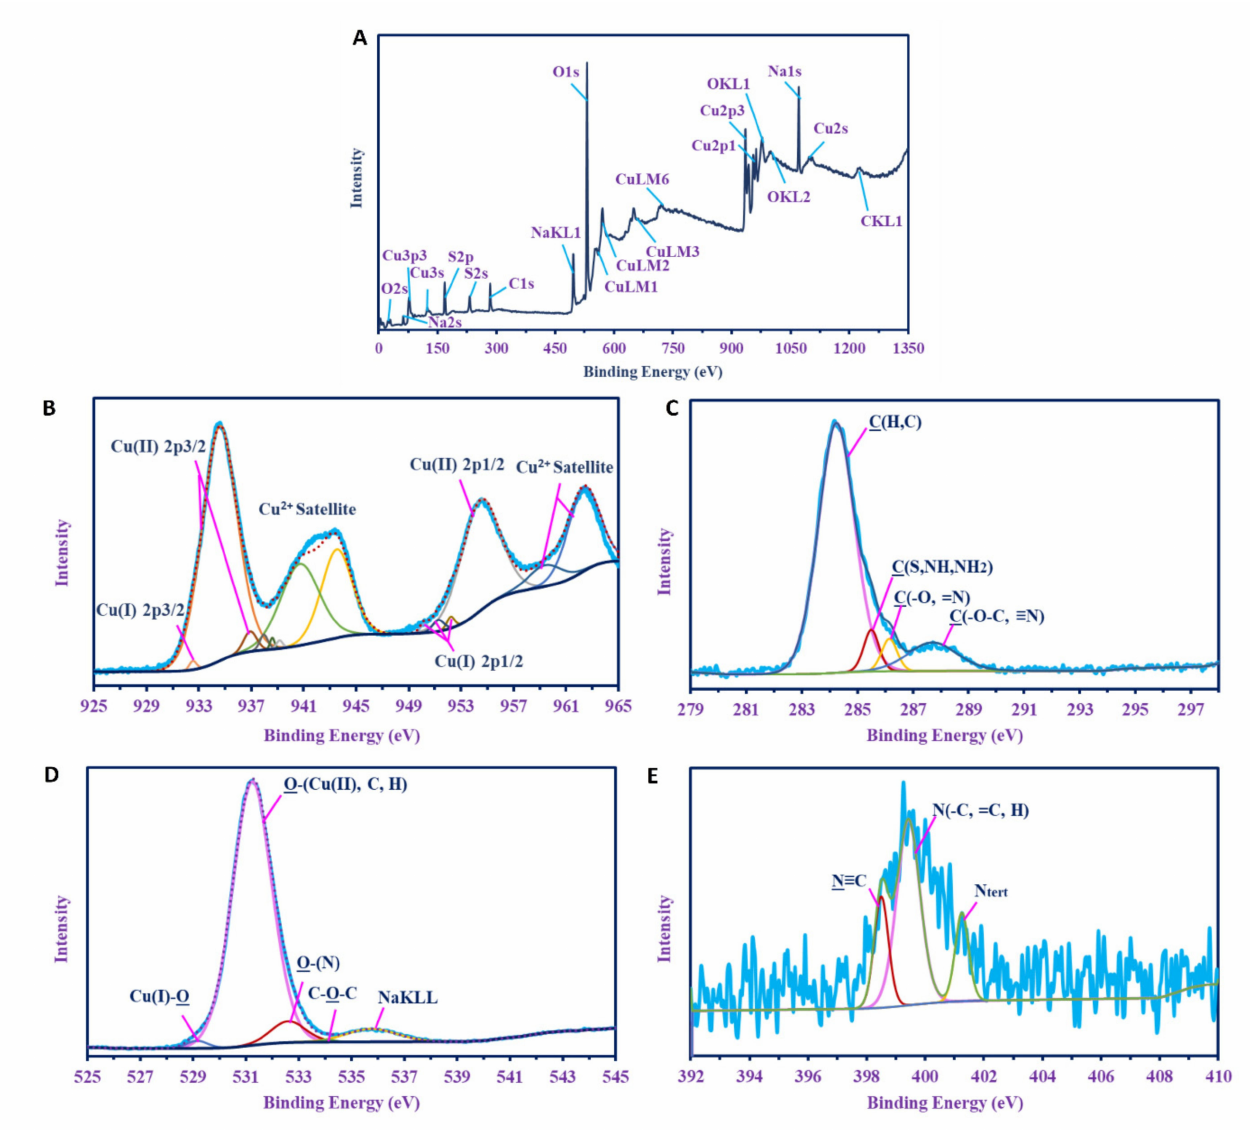
Figure 4. XPS analysis of CuO-NPs synthesized by A. niger strain G3-1. ( A ) Overall survey; ( B ) core CuO-NPs; ( C – E ) C 1s, O 1s, N 1s, respectively, of